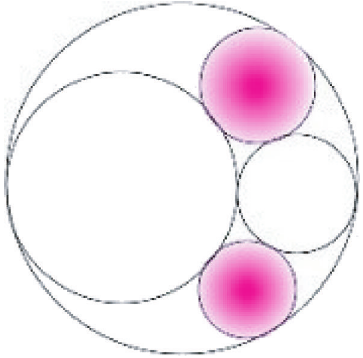
Figure 3.6. The construction of Apollonios of Perge (see